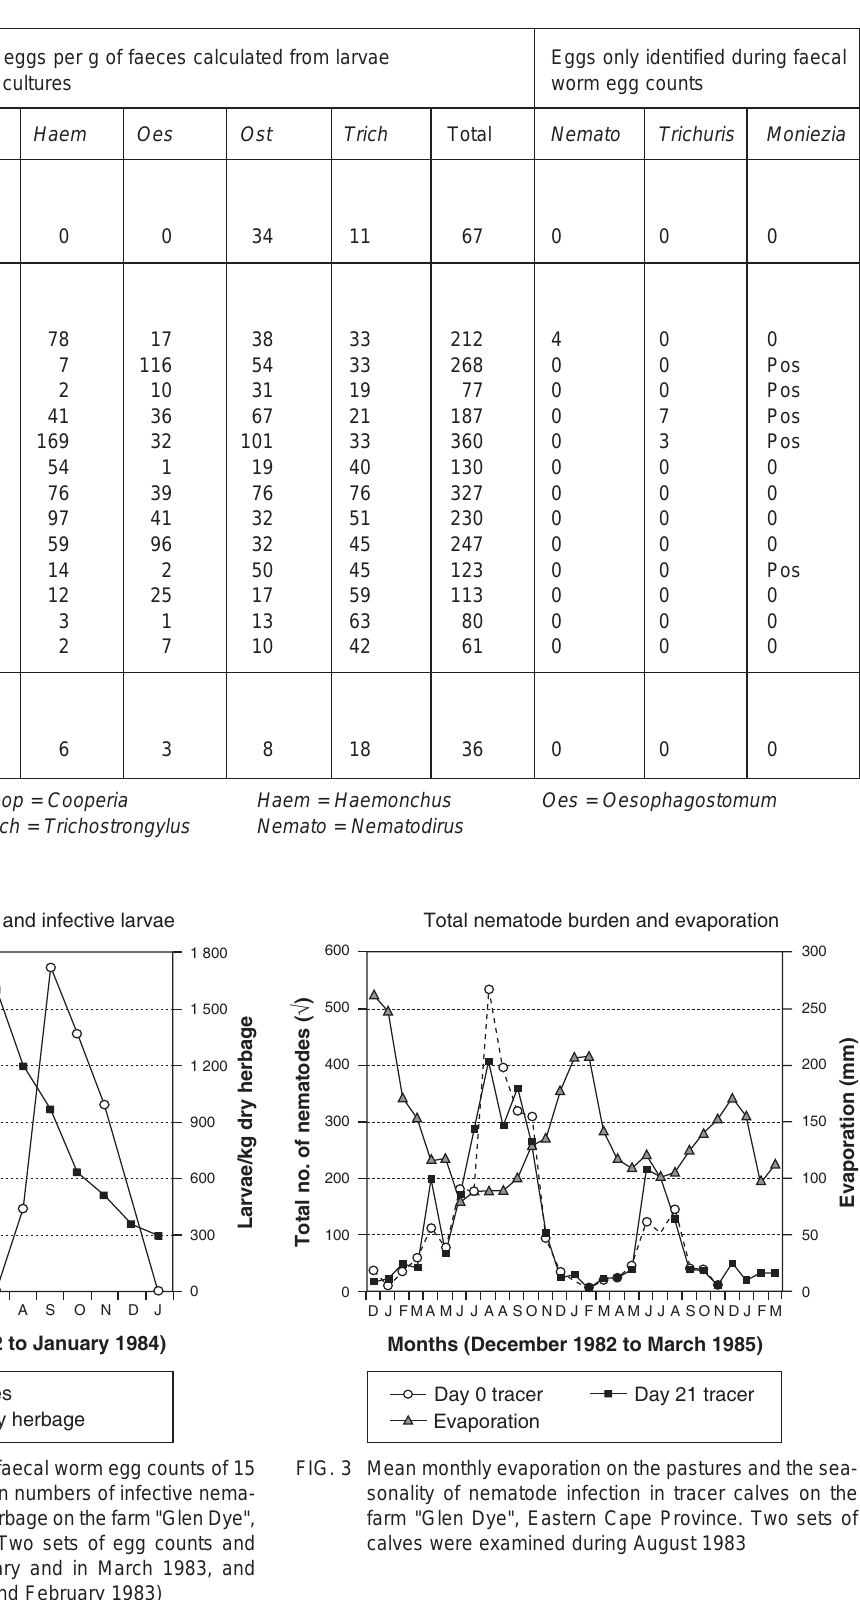
FIG. 2 Three point moving mean faecal worm egg counts of 15 untreated heifers and mean numbers of infective nema- tode larvae per kg of dry herbage on the farm "Glen Dye", Eastern Cape Province. (Two sets of egg counts and larval collections in January and in March 1983, and none in December 1982 and February 1983)